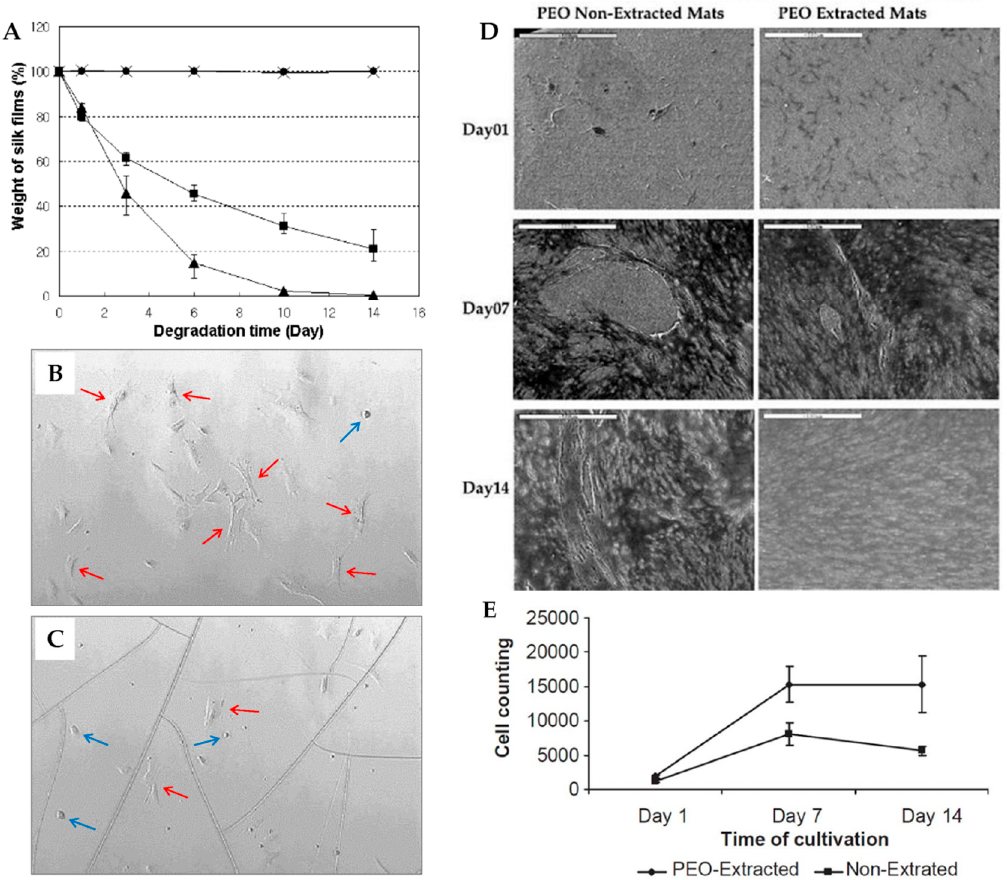
Figure 4. ( A ) Enzymatic degradation of SF films. ( ▲ : SF films by water annealing in enzyme solution; ■ : SF films by methanol treatment in enzyme solution; ×: SF films by water annealing in PBS; ● : SF films by methanol treatment in PBS), n = 5; Human bone-marrow stromal cells (hMSCs) attachment at 2 h on water-annealed SF film ( B ) and methanol-treated SF film ( C ). The cracks on the film in image ( C ) are induced by methanol treatment. Red arrows indicate fully attached cells and blue arrows indicate attaching cells. Reproduced from [56]; ( D ) SEM images of bone-marrow stromal cells (BMSCs) growing on polyethylene oxide (PEO) non-extracted and PEO extracted SF mats, respectively, after 1, 7, and 14 days. Scale bar: 500 µ m; ( E ) Proliferation of BMSCs grown on SF mats. Seeding density: 2.5 E4 cells/cm 2 , n = 4. Reproduced from [59].